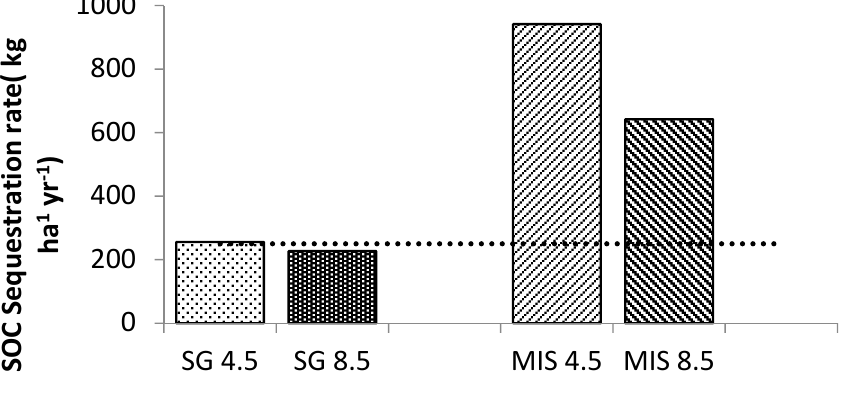
Figure 5. DayCent predicted average SOC sequestration rate over the entire simulation period (2009-2100). SG 4.5 = switchgrass at RCP 4.5; SG 8.5 = switchgrass at RCP 8.5; MIS 4.5 = miscanthus at RCP 4.5; MIS 8.5 = miscanthus at RCP 8.5.